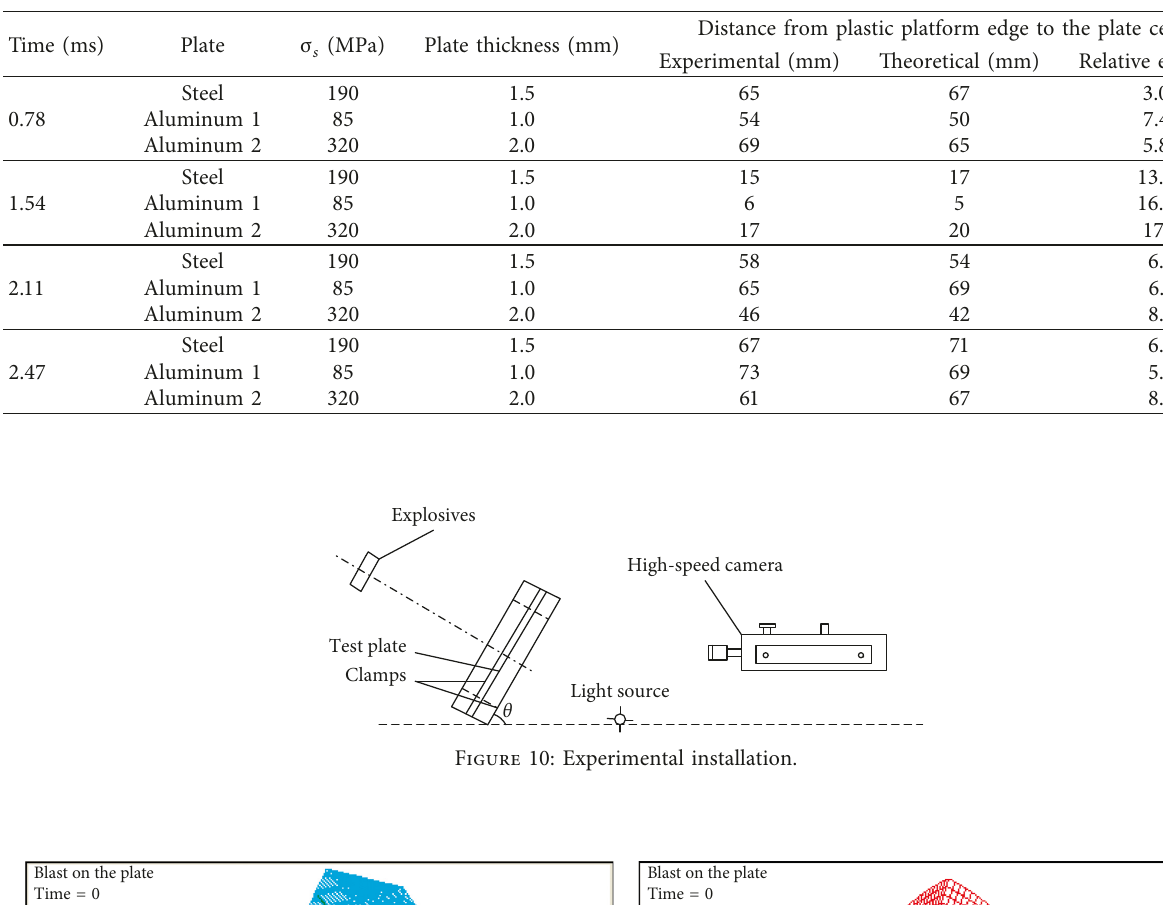
Table 1: Comparisons of theoretical and experimental results.